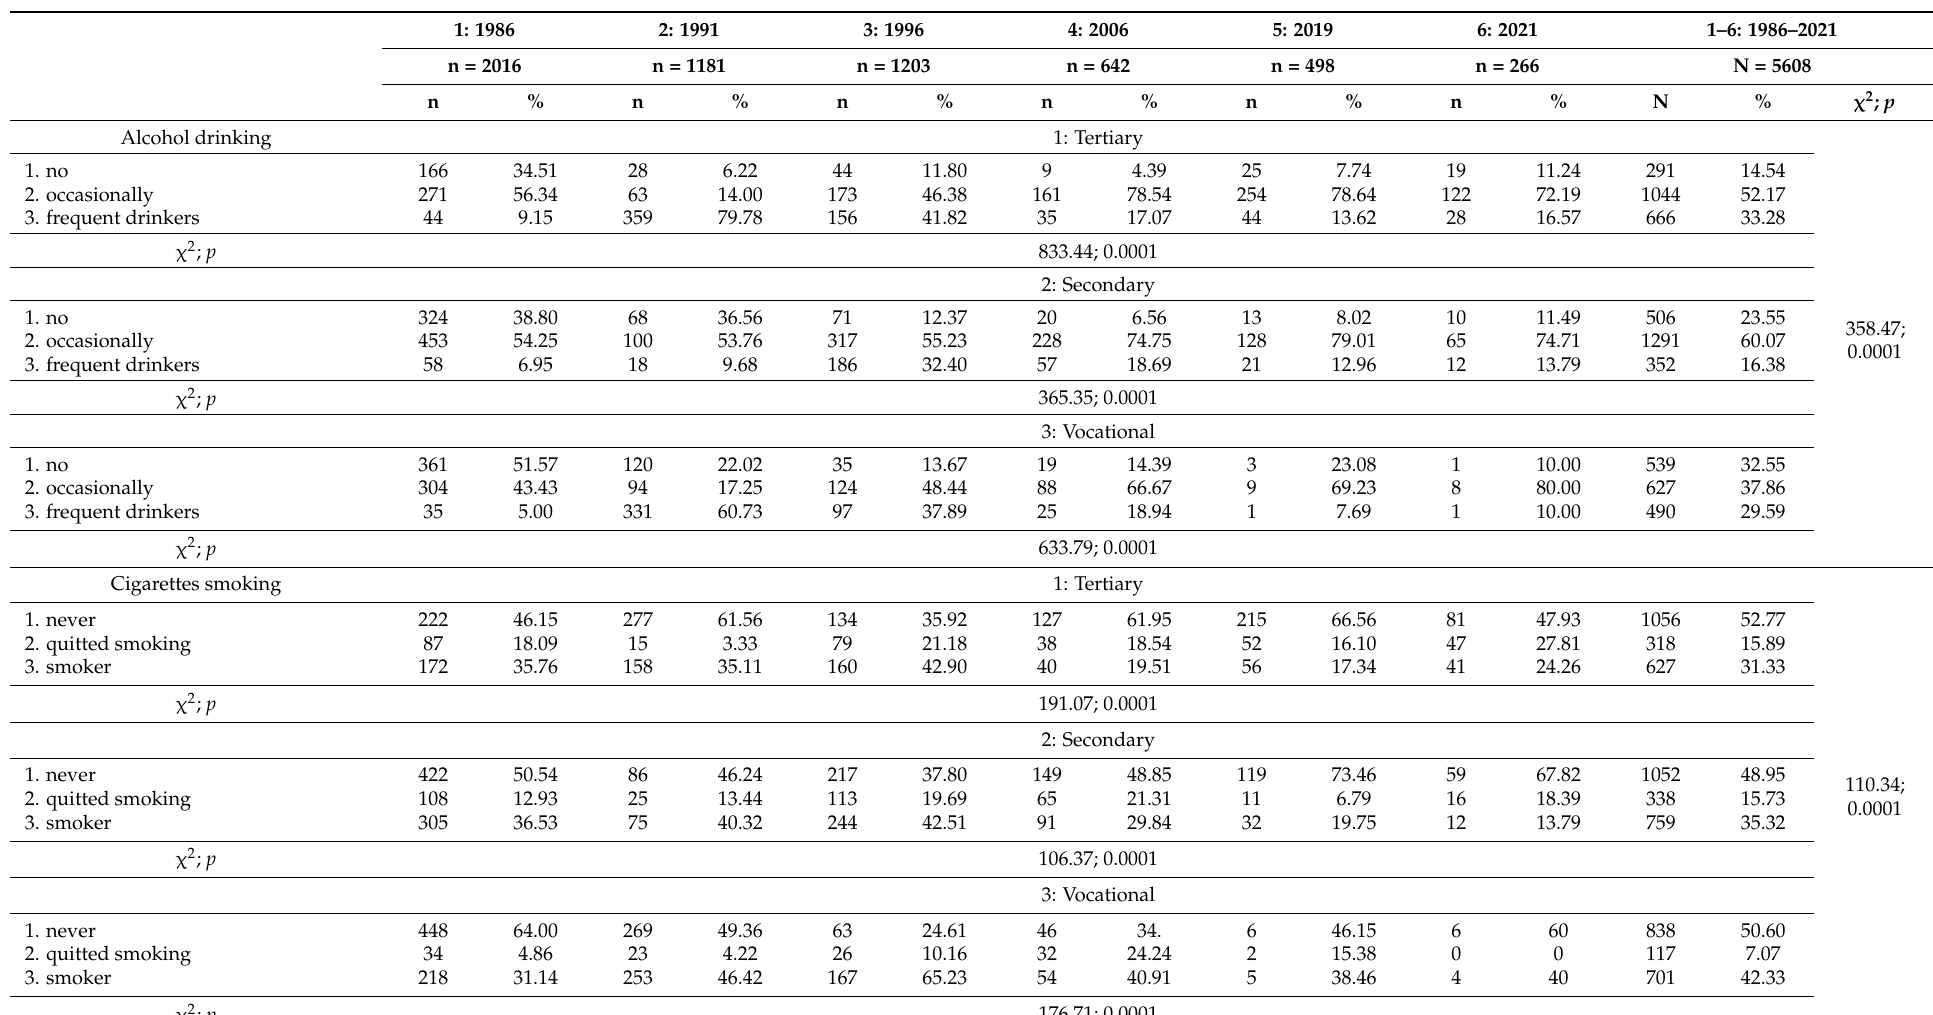
Table 2. Characteristics of women’s lifestyle in educational level and in particular years (N, percentages—%), the importance of the differences between years within educational level (Chi-square test, p —the level of significance) and the importance of the differences between educational level (Chi-square test, p —the level of